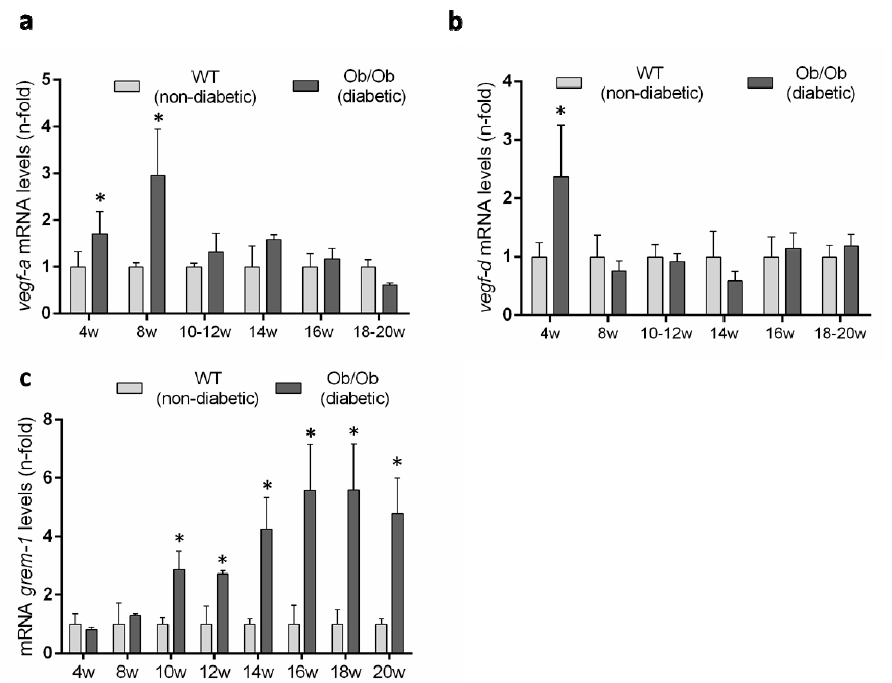
Figure 8. Gene expression levels of VEGFR ligands in the BTBR ob / ob experimental model. ( a ) vegf-a , ( b ) vegf-d and ( c ) grem-1 were evaluated by a real-time polymerase chain reaction. mRNA levels in each sample were normalized by cyclophilin 1. Occurring at each time point, data were normalized by the mean value of their corresponding controls. Data as mean ± SEM of 6–8 mice per group. * p < 0.05 versus control non- diabetic, # p < 0.05 versus diabetic.